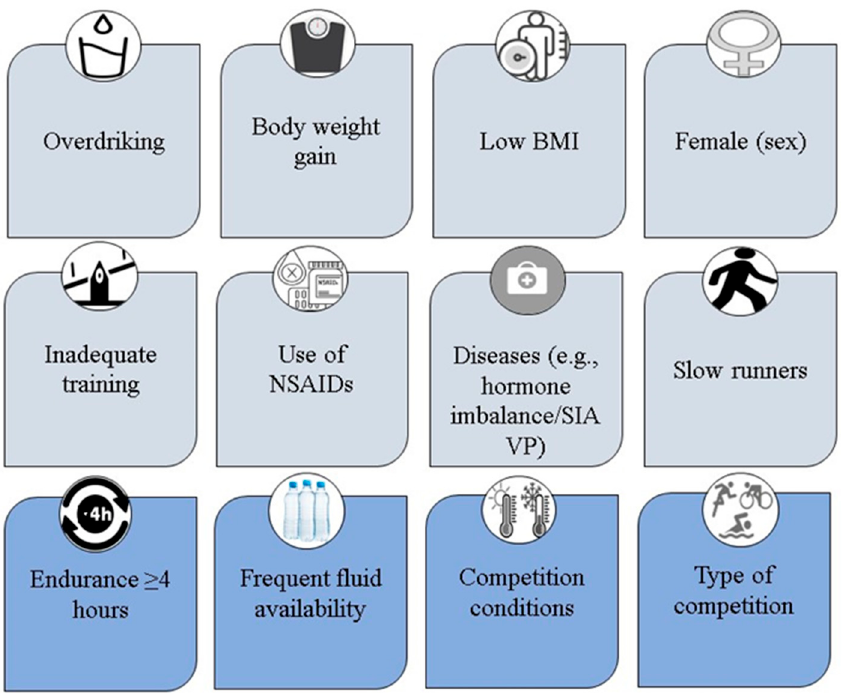
Figure 1. Illustration of person-related (potential) risk factors and event-related risk factors for exercise-associated hyponatremia. BMI, body mass index; NSAIDs, Non-steroidal anti-inflammatory drugs; SIAVP, Syndrome of inappropriate antidiuretic hormone secretion.